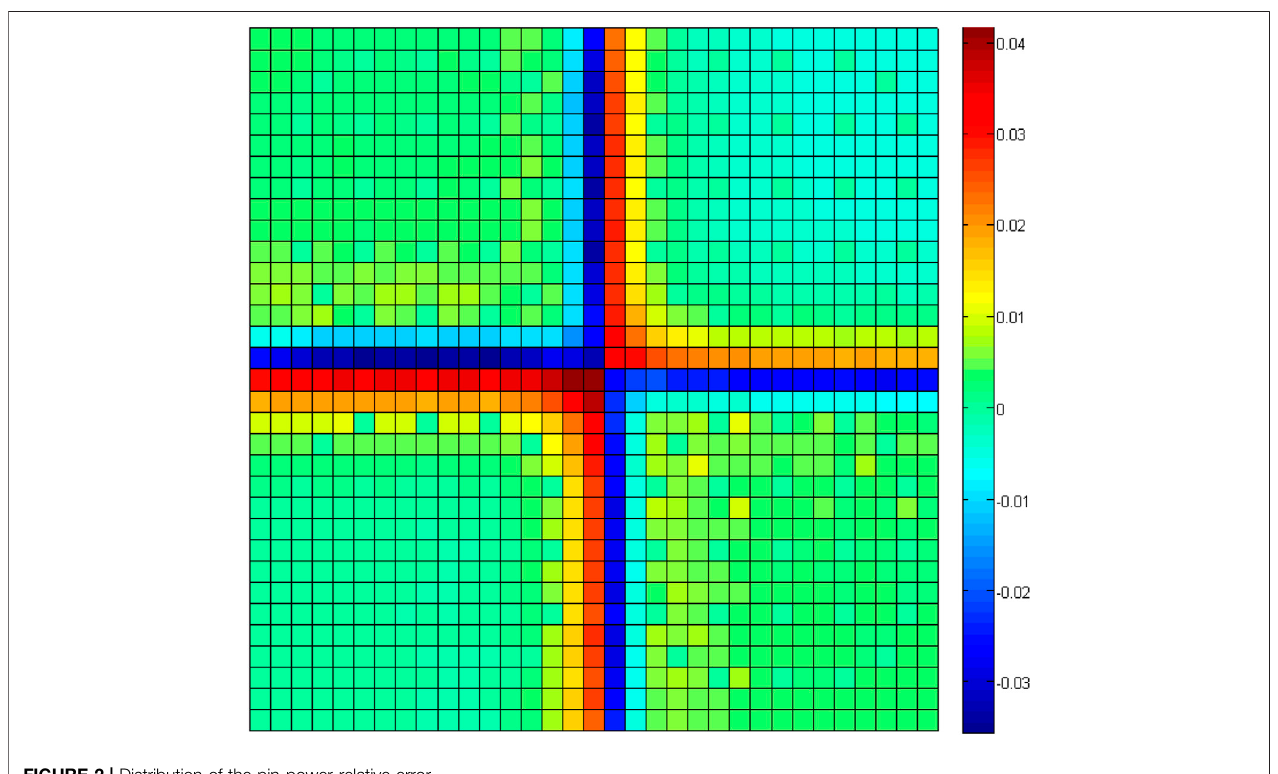
FIGURE 2 | Distribution of the pin-power relative error.